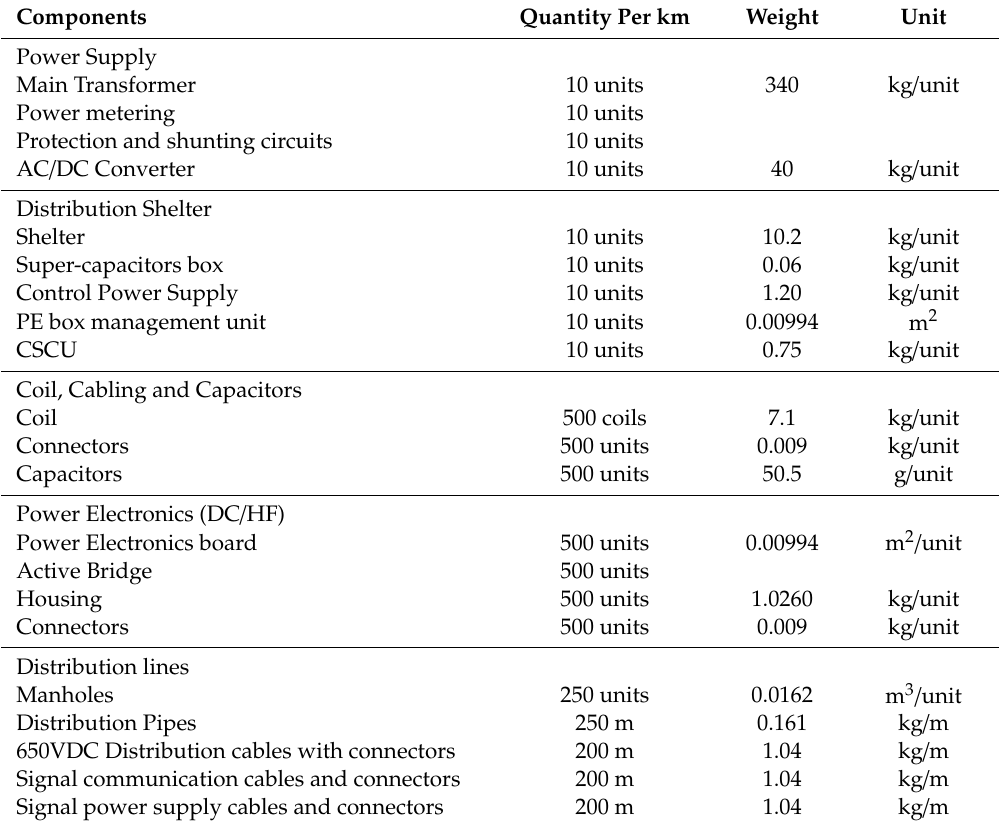
Table 3. Wireless power transfer (WPT) components per km of e-road.